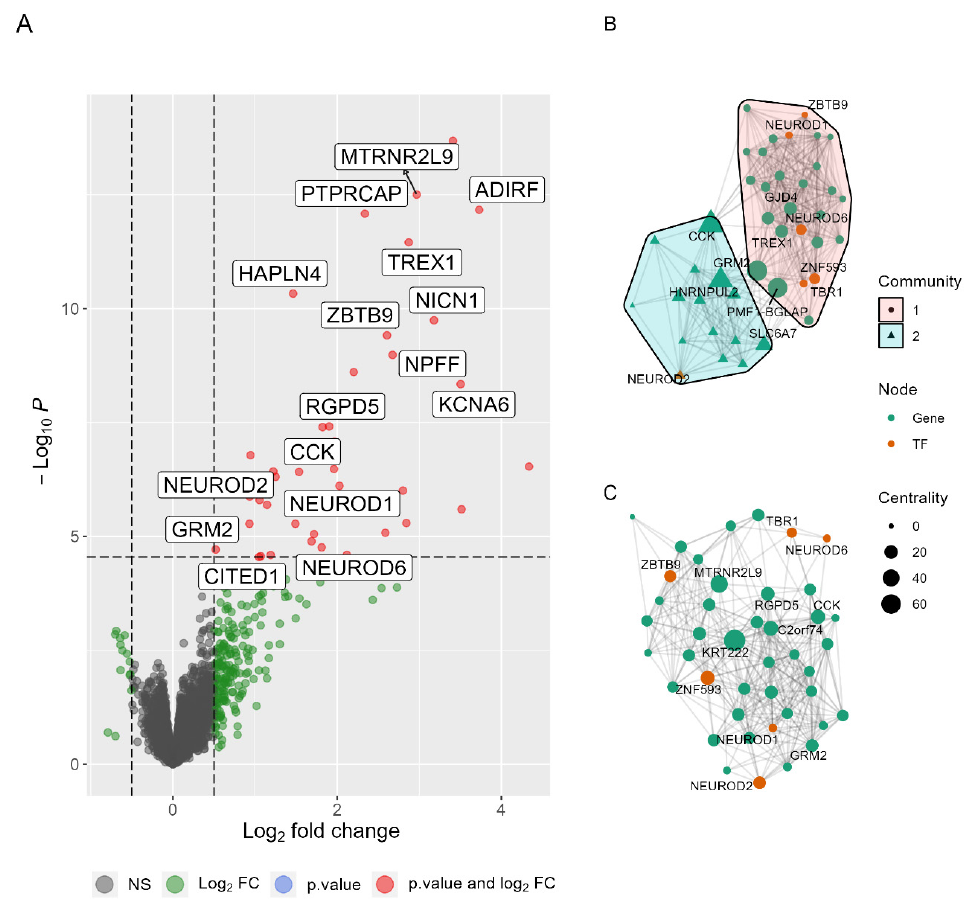
Figure 2. Differences between PDC1 and PDC2 gene expression. ( A ) Volcano plot reporting differences in gene expression where red points were DEGs. ( B ) Gene network for PDC1 showing nodes are segregated into 2 communities. ( C ) Gene network for PDC2, showing no segregation in communities. Both networks were built with the Kamada–Kawai layout, where each node is a gene and each edge is a PCIT value between genes.